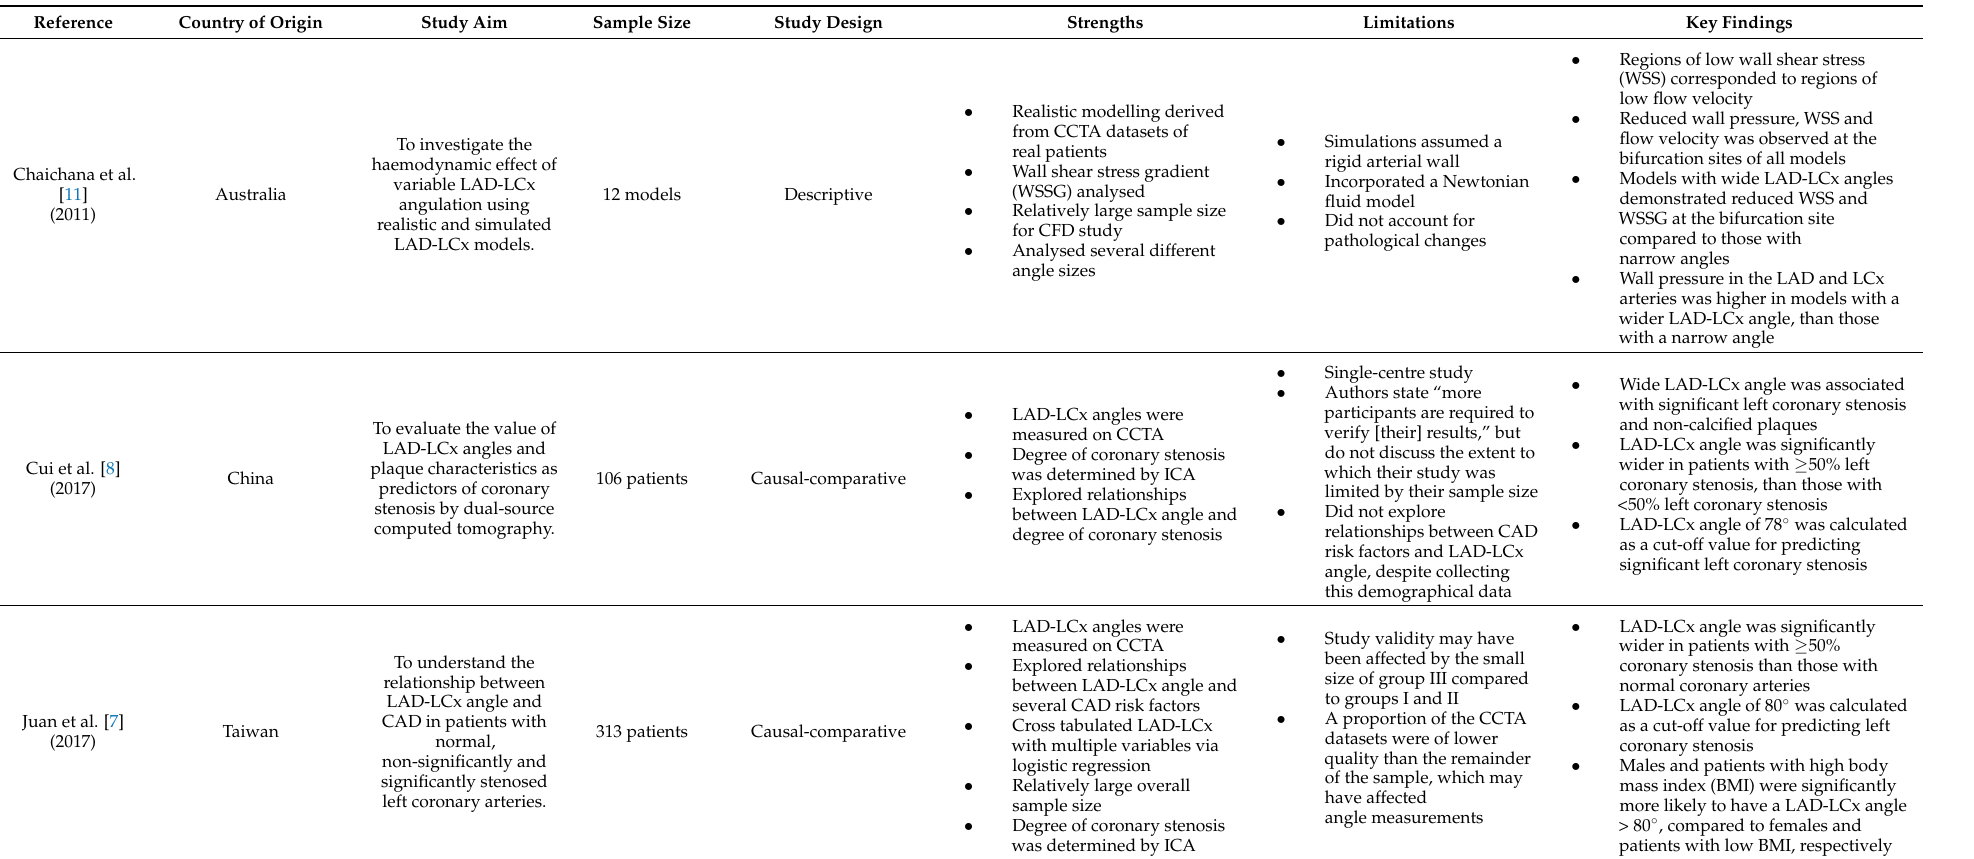
Table 2. Study characteristics, strengths, limitations, and